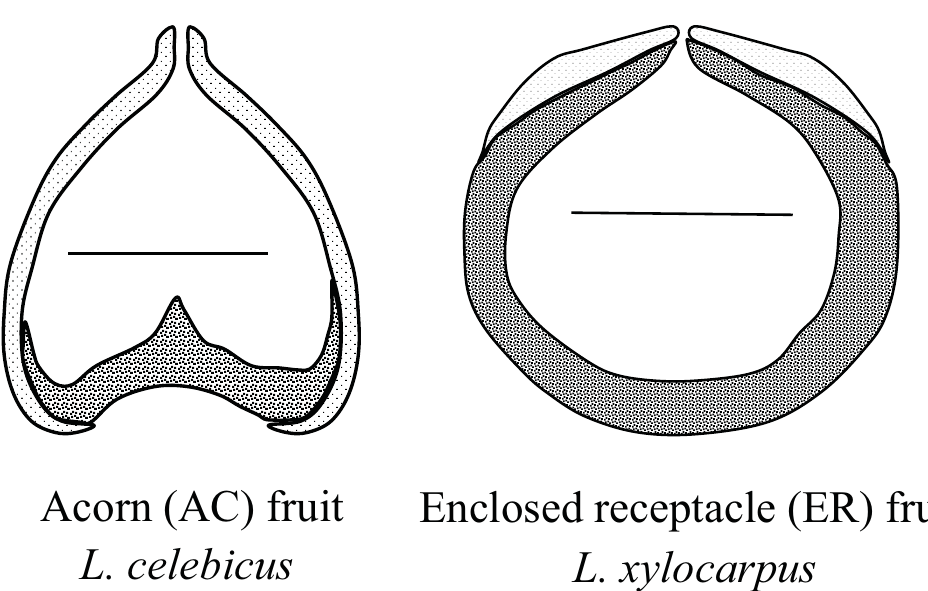
PLOS ONE | https://doi.org/10.1371/journal.pone.0199538 June 26,